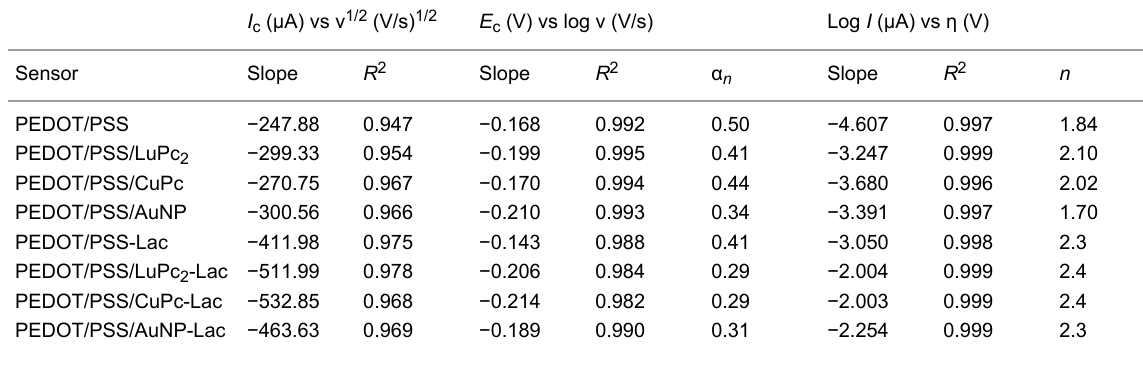
Table 4: Relationship between scan rate in sensors immersed in hydroquinone 10 − 3 mol·L − 1 calculated in the cathodic